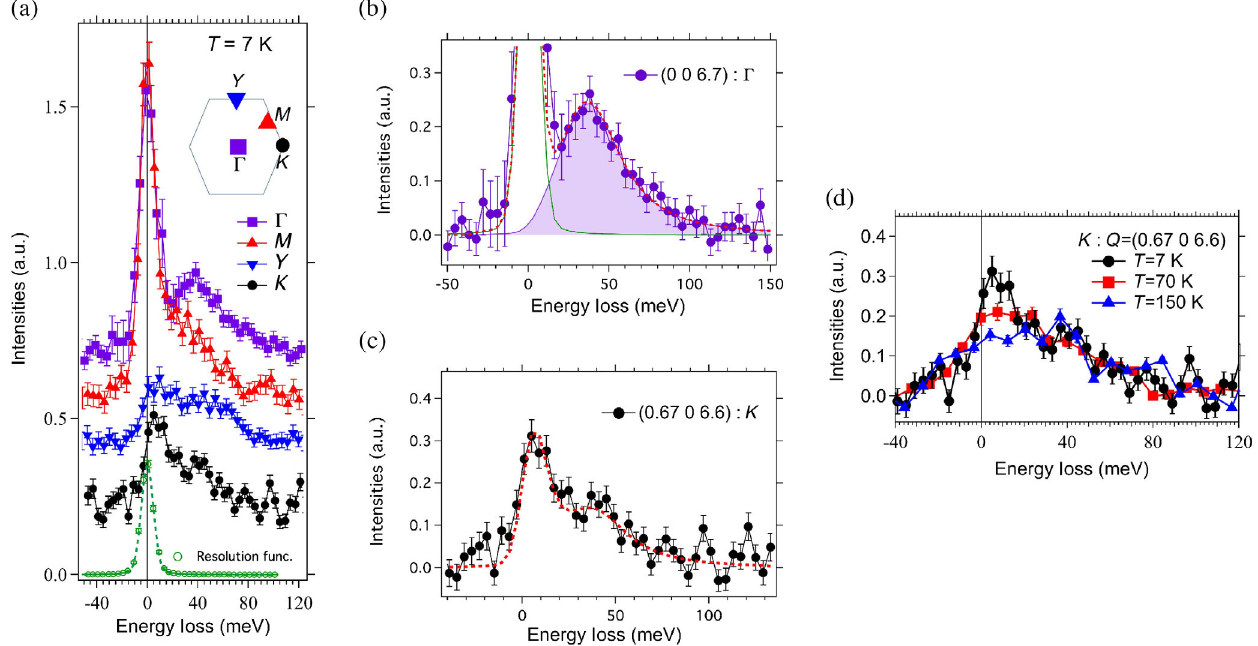
FIG. 2. High-resolution RIXS spectra recorded at T ¼ 7 K. (a) The measured energy resolution function of the quartz analyzer is plotted at the bottom. At Q ¼ ð 0 0 6 . 75 Þ ( Γ ), an elastic scattering is followed by a broad excitation without any indication of a narrow excitation. At Q ¼ ð 0 . 45 0 . 45 6 . 5 Þ (near M ), a soft low-energy excitation is unresolved with 12 meV energy resolution, and a quasielastic scattering is followed by a broad shoulder excitation. At Q ¼ ð 0 1 6 . 5 Þ ( Y ), a low-energy excitation is seen with a broad high-energy feature. At Q ¼ ð 0 . 67 0 6 . 6 Þ ( K ), a narrow excitation is discovered at a low energy. (b),(c) The measured RIXS spectra at the Γ and K wave vectors, respectively, are fit by the pseudo-Voigt function (elastic scattering) and damped harmonic oscillator (DHO) function convoluted by the 12 meV resolution function. (d) Temperature dependence of the RIXS excitation spectrum at the K point. The low-energy peak shows a clear decrease at T ¼ 70 K and becomes featureless at T ¼ 150 K, indicating that it is an excitation peak of the zigzag magnetic